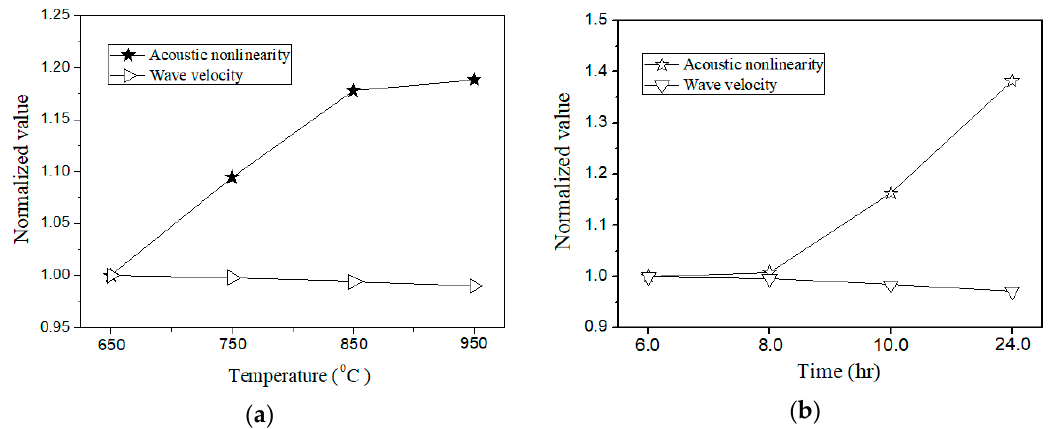
Figure 11. Comparison of the sensitivity of acoustic nonlinearity and linear parameters for the specimens subjected to ( a ) thermal loading temperature with two hours’ holding time (by the reference of β R = 0.197, C g = 3.346 mm/ µ s that of the specimen subjected 650 ◦ C thermal loading), and ( b ) different thermal loading time at the temperature of 750 ◦ C (by the reference of β R = 0.363, C g = 3.332 mm/ µ s that of the specimen subjected 6 hours’ thermal loading).